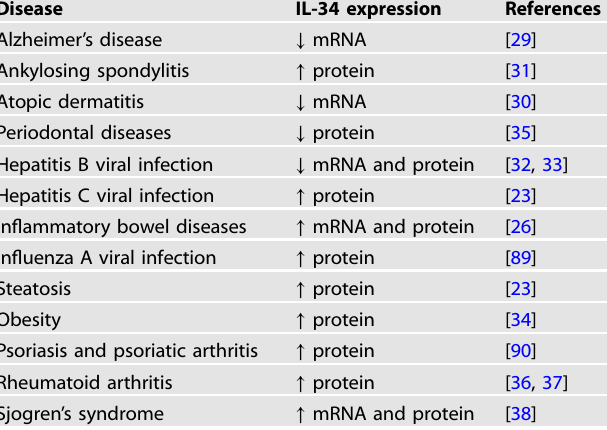
Fig. 1 Schematic view of interleukin (IL)-34 receptors and IL-34-induced signalling pathways. M-CSF-1-R macrophage colony-stimulating factor receptor, NF- κ B nuclear factor kappa-light-chain-enhancer of activated B cells, PI3K phosphoinositide 3-kinase, MAPK mitogen-activated protein kinase, ERK1/2 extracellular signal-regulated protein kinases 1 and 2, JNK c-Jun N-terminal kinase, JAK Janus kinase, STAT3 signal transducer and activator of transcription 3, ULK1 UNC-51-like Kinase 1, PTP- ζ protein-tyrosine phosphatase zeta, FAK focal adhesion kinase, TAMs tumour-associated macrophages. Table 1. Changes of IL-34 expression in human